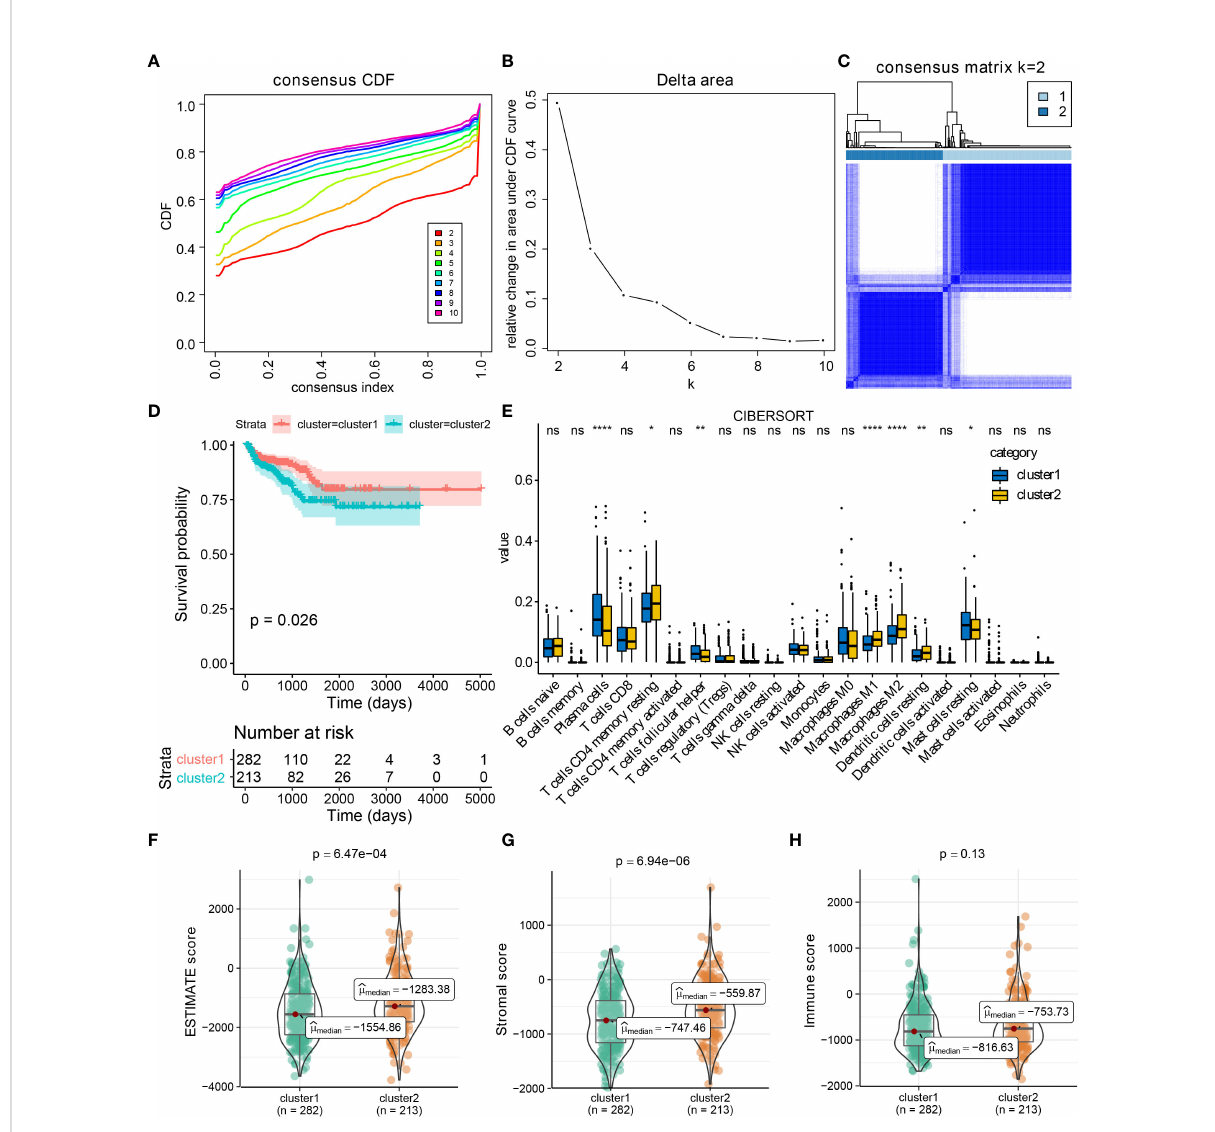
FIGURE 2 CXCL14, CCL20, CCL24, and CCL26 de fi ned the TCGA-PRAD samples into two clusters. Results of consensus cluster analysis in TCGA-PRAD cohort based on CXCL14, CCL20, CCL24, and CCL26 expression levels (A – C) , and survival analysis between cluster1 and cluster2 (D) . The immune pro fi les of PCa in cluster1 and cluster2 by CIBERSORT method (E) . The distribution of ESTIMATE, immune, and stromal scores in PCa patients from different clusters (F – H) . *p < 0.05; **p < 0.01; ****p < 0.0001; ns: not signi fi